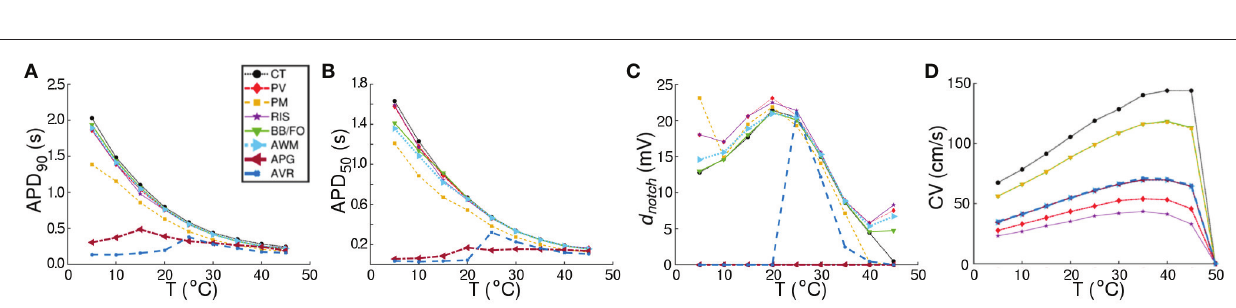
FIGURE 3 | Temperature-dependence of RMP, and minimum stimulus ( χ , in Coulombs) required to produce an action potential, in normal (A,C) and remodeled (B,D) cardiac cells, isolated from different regions of the human atria (CT, AVR, APG, PM, and AWM ∗ ).